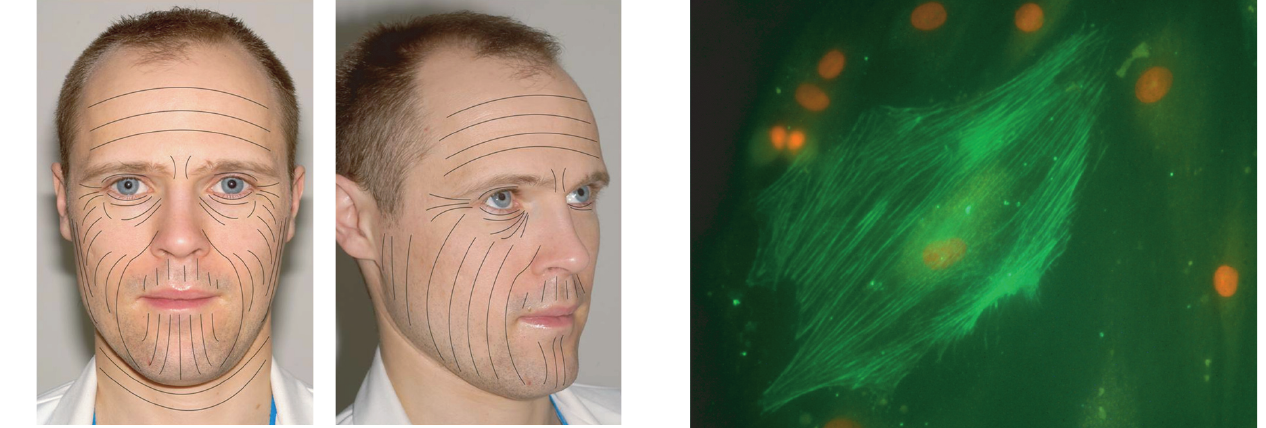
Figure 1: The lines of Langer or relaxed skin tension lines. away from anatomical sites prone to pathological scarring such as shoulders, sternum, across joints, or near orifices. Wounds should be closed with the minimum possible tension and paper tape applied to redistribute the tension over a greater surface area. Infection, foreign bodies (e.g., all contribute to poorer scarring [5].